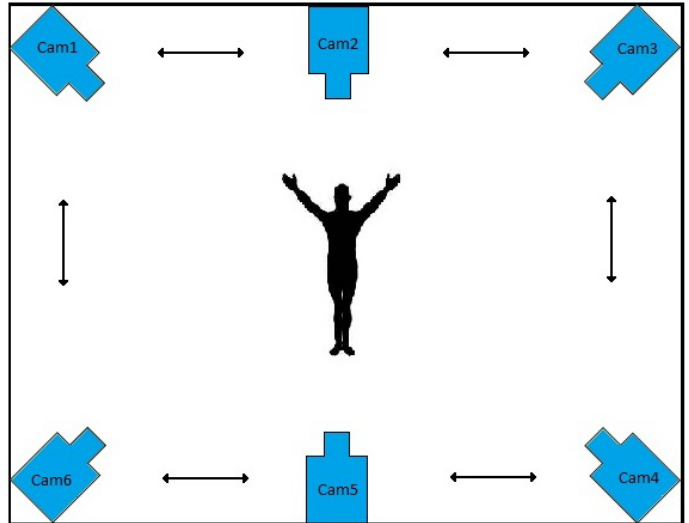
Figure 2. Sample camera network setup for human activity